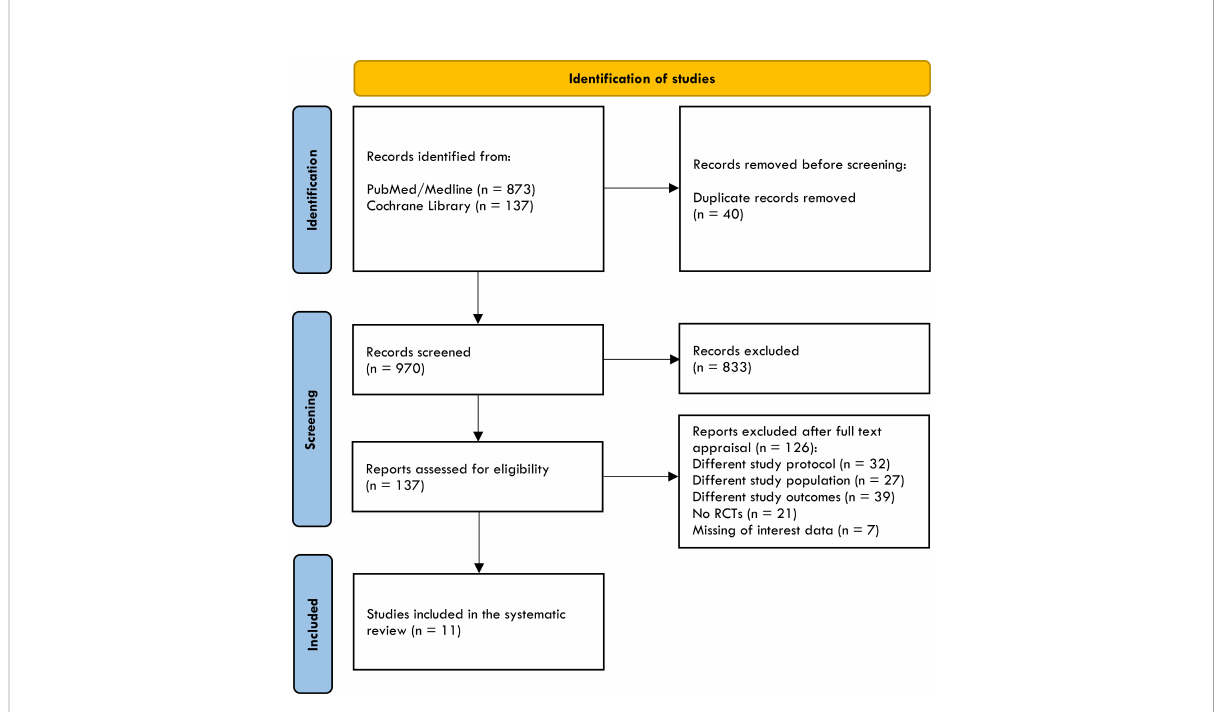
FIGURE 2 The PRISMA fl ow diagram of included